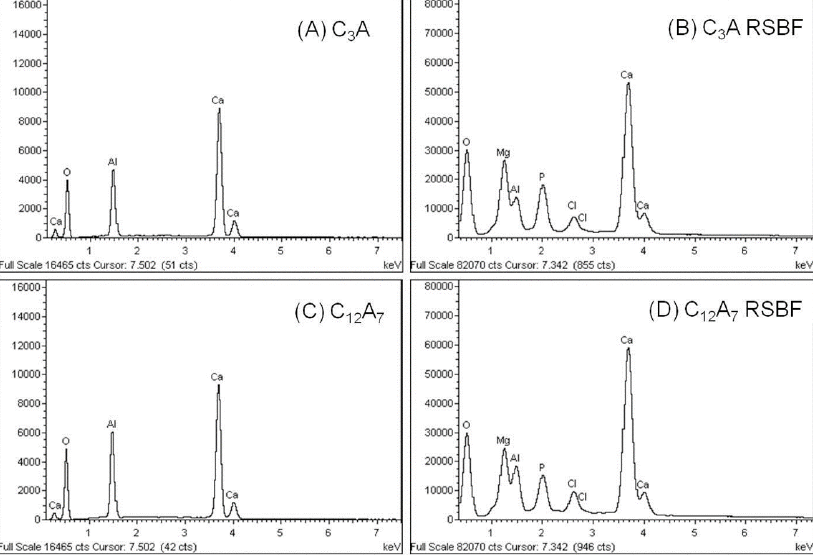
A, (C) C A and after 7 days in SBF Rigo: (B) C 3 12 7